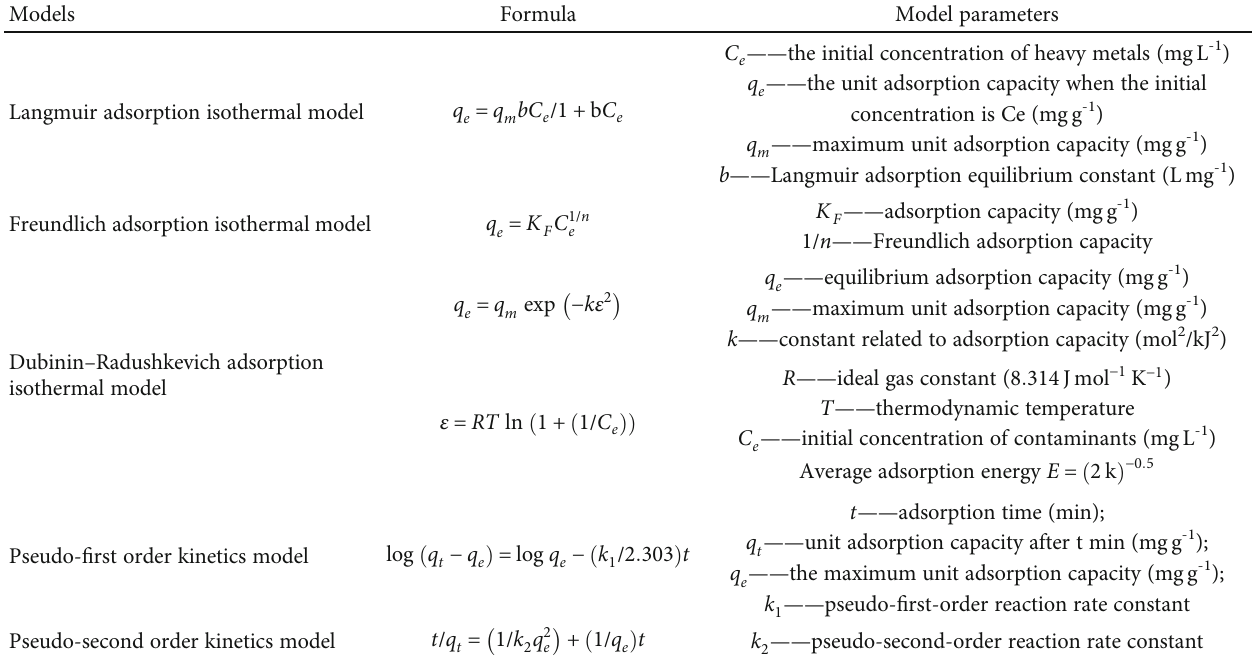
Table 1: Thermodynamic and kinetics models of heavy metals adsorption on